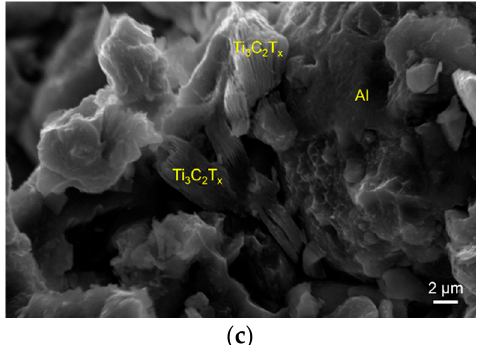
Figure 3. SEM micrographs of the initial powders ( a ), and polished surface ( b ) and fracture surface ( c ) of the samples sintered at 650 °C in Ar for 1 h. The left- and right-hand side micrographs in ( a ) show the morphologies of Al and Ti 3 C 2 T x powders, respectively.